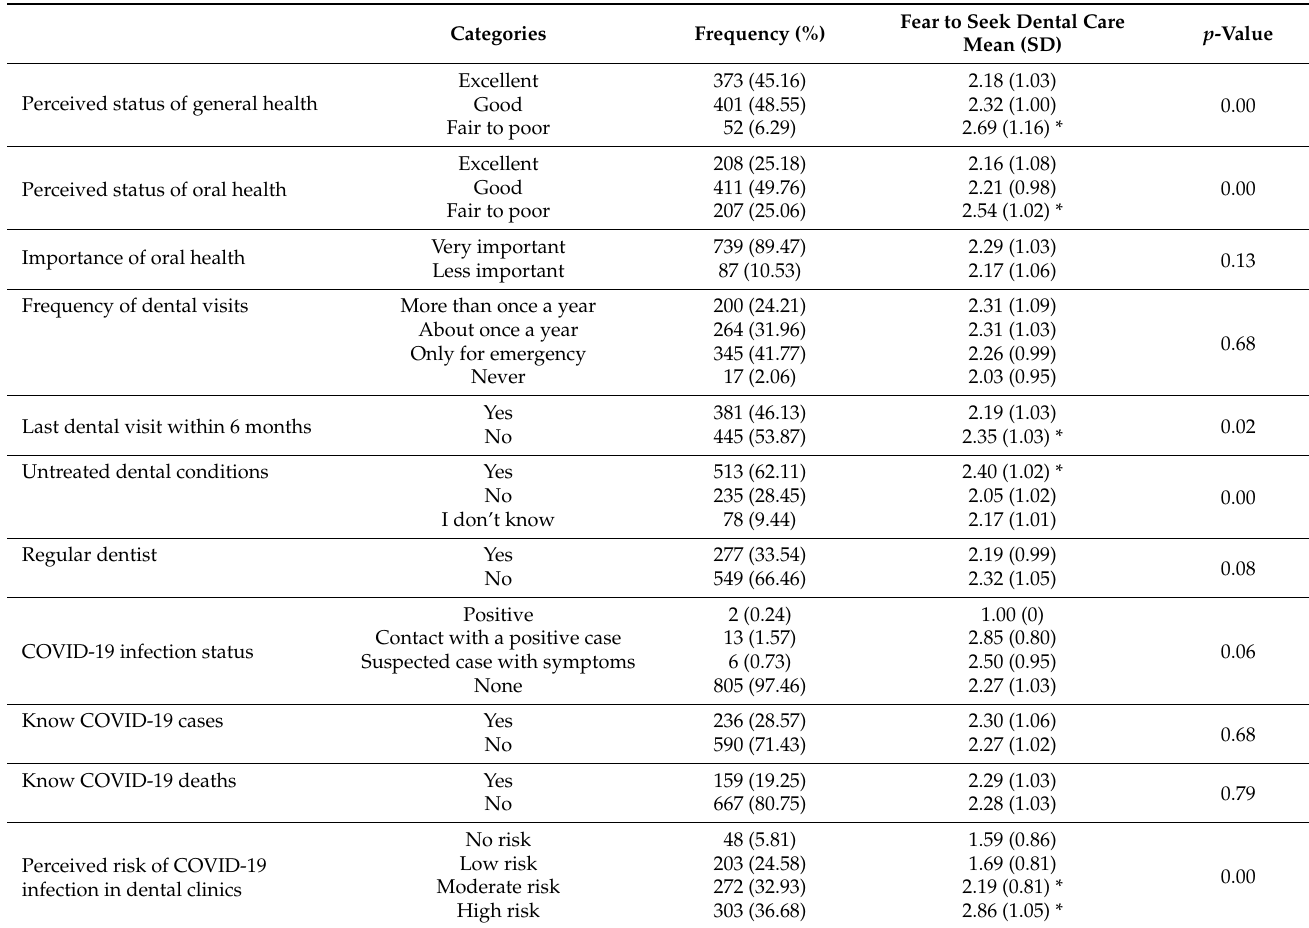
Table 2. Comparison of fear to seek dental care during COVID-19 outbreak by key variables presented by means and standard